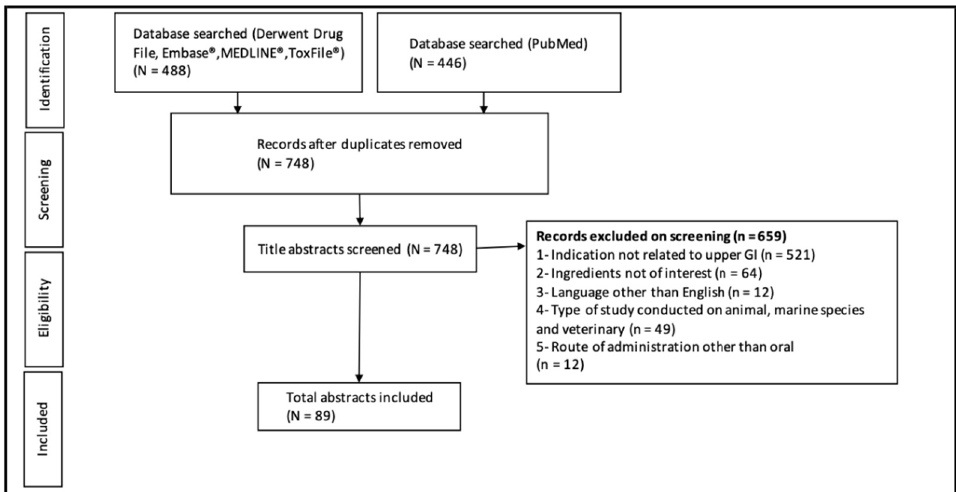
Figure 1. Flow diagram of the literature search process .